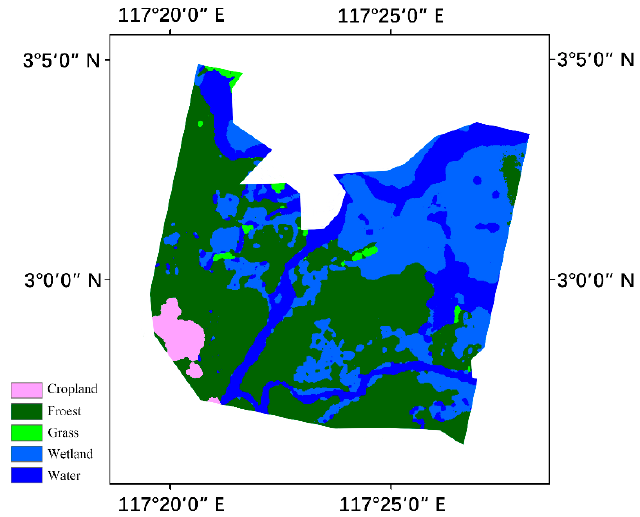
Figure 9. Optimal prediction map (with the added auxiliary data).